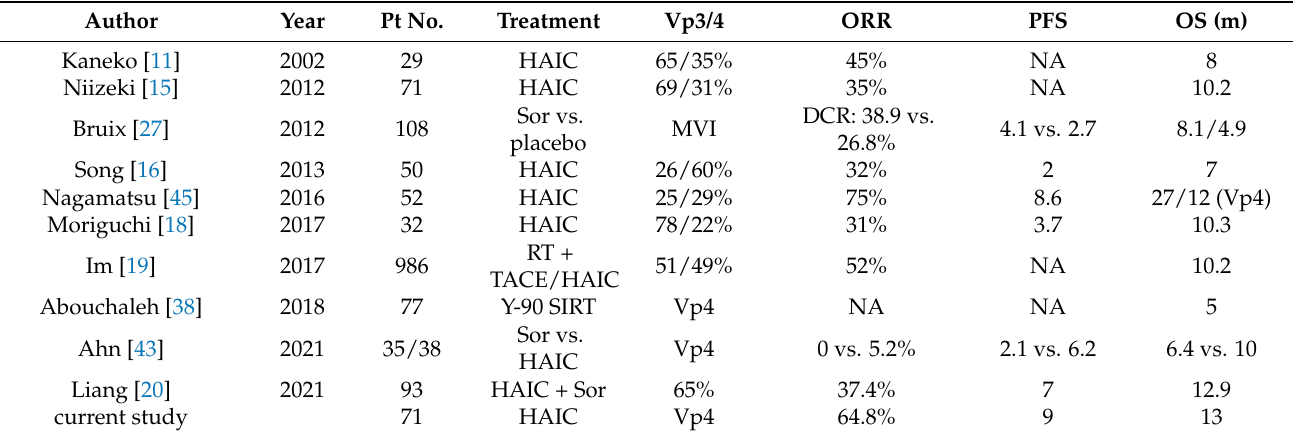
Table 4. Comparison of clinical outcomes treated by different modalities for HCC patients with major PV